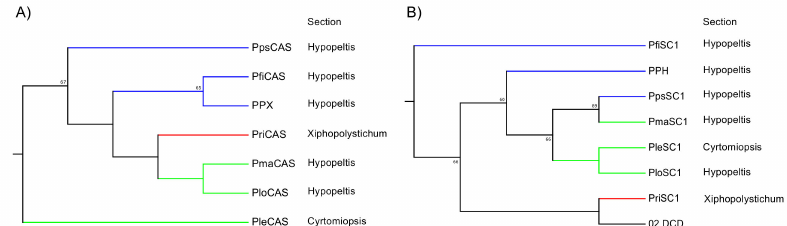
Figure 5. Phylogenetic analysis of Polystichum triterpene synthases. ( A ) Expanded Polystichum CAS clade. ( B ) Expanded Dryopteridaceae SC clade. Bootstrap values with 1000 replicates are shown at the nodal branches (cutoff value = 50%). Blue, red, and green branches indicate groups 1, 2, and 3, respectively. These are categorized by their triterpene-based chemotaxonomy. DCD is a dammaradiene synthase from Dryopteris crassirhizoma . PPX and PPH are a CAS and hydroxyhopane synthase from Polystichum polyblepharum , respectively. Pfi, P. fibrilloso-paleaceum ; Ple, P. lepidocaulon ; Plo, P. longifrons ; Pma, P. makinoi ; Pps, P. pseudo-makinoi ; Pri, P. rigens